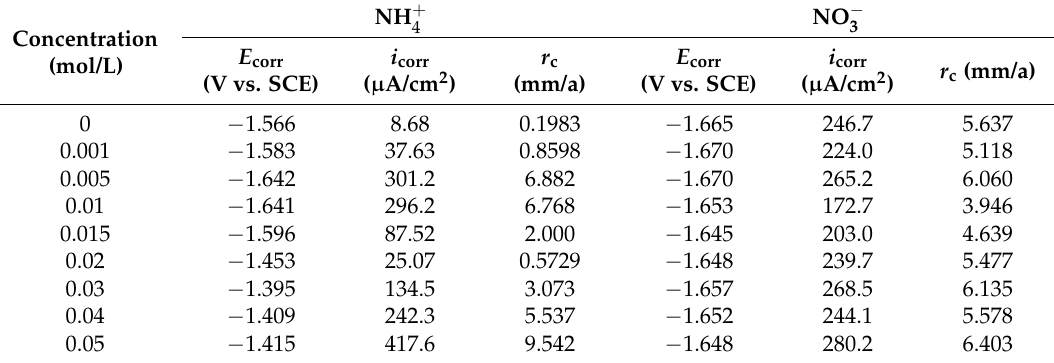
Table 3. Tafel extrapolation evaluated E corr , i corr and r c values of AZ91D at solutions of different NH + and NO - concentration. 3